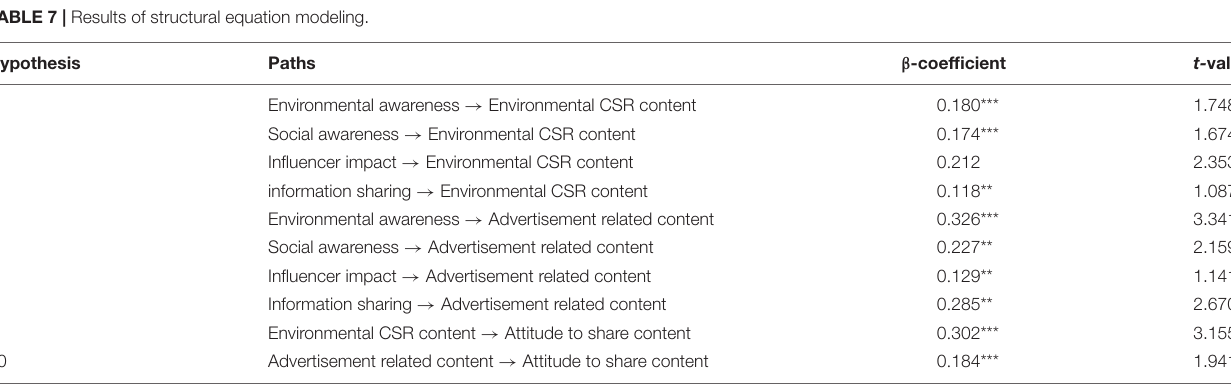
FIGURE 1 | Structural path analysis. Goodness of Fit indices for the proposed research model. ***Means 1% significance level. TABLE 7 | Results of structural equation modeling.